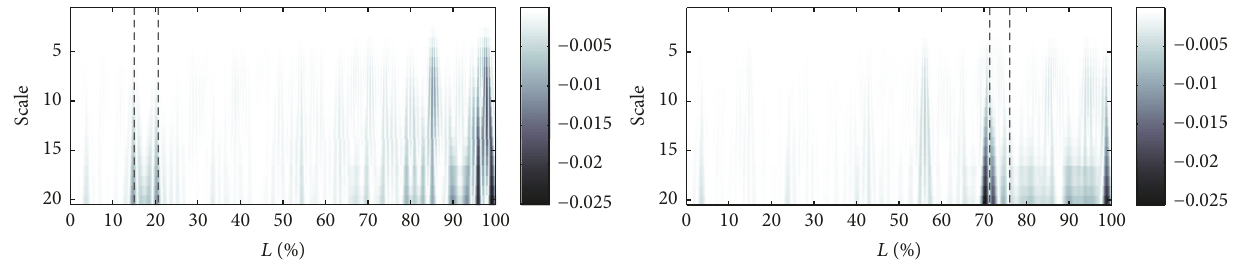
Figure 18: Scalograms of the 8th mode of natural vibrations obtained in the case of six interpolation